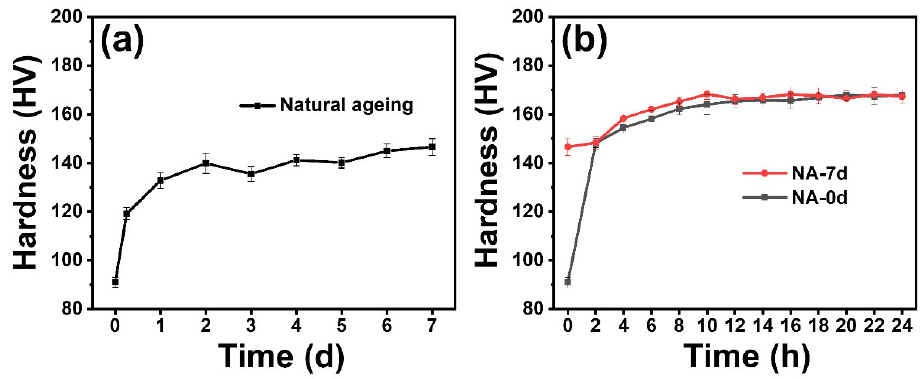
Figure 1. Age ‐ hardening curves of ( a ) natural ageing treatment during 7 days and ( b ) NA ‐ 0d and Figure 1. Age-hardening curves of ( a ) natural ageing treatment during 7 days and ( b ) NA-0d and NA ‐ 7d samples aged at 120 °C for different holding times from 0 to 24 h. NA-7d samples aged at 120 ◦ C for different holding times from 0 to 24